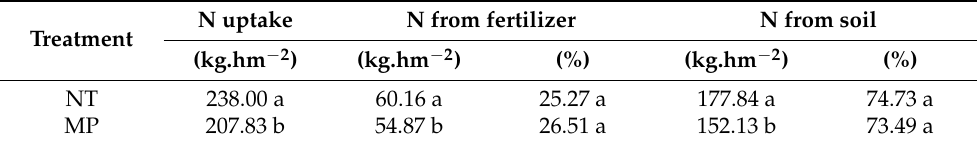
Table 1. Effects of tillage practices on distribution of N from different sources in plants.